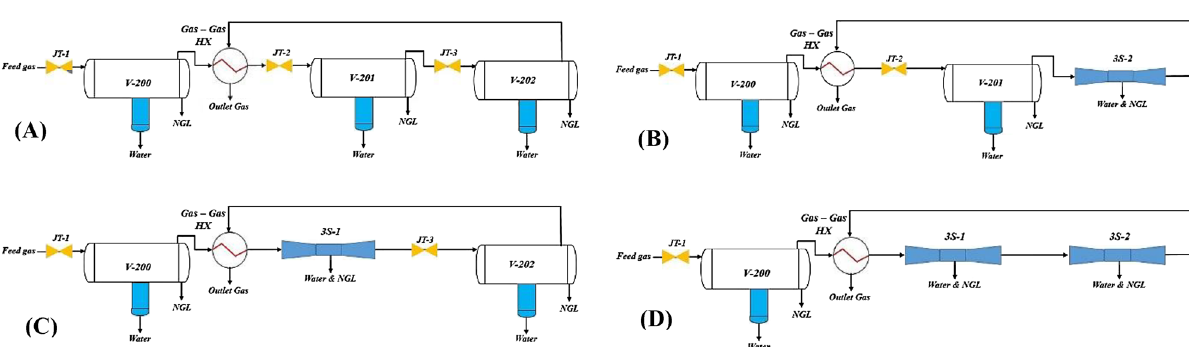
Figure 4. Schematic diagram of ( A ) JT process (configuration A), ( B ) integrated JT + 3S process (configuration B), ( C ) integrated 3S + JT process (configuration C), and ( D ) 3S process (configuration